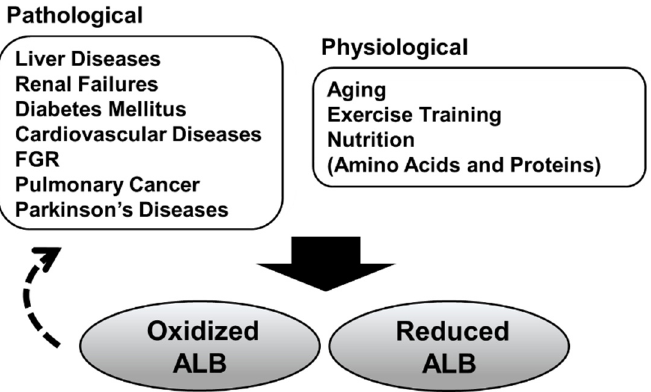
Figure 3. Pathological/physiological conditions associated with the serum albumin redox state. Increased oxidized albumin (ALB) has been observed in pathological and physiological conditions. Some recent studies have suggested that oxidized serum ALB isoforms per se could be involved in the progression of these diseases (dashed arrow). Furthermore, it has become evident that serum ALB redox state is also associated with protein nutritional status.